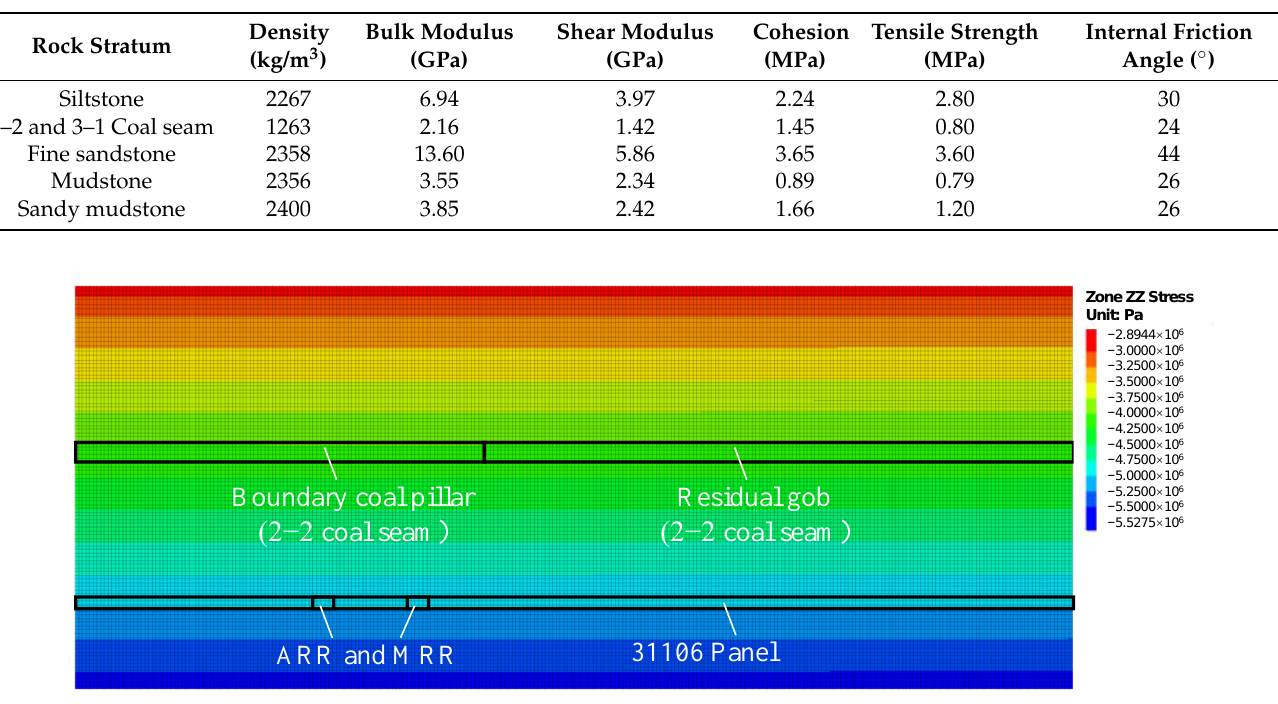
Table 2. Mechanical parameters of model.